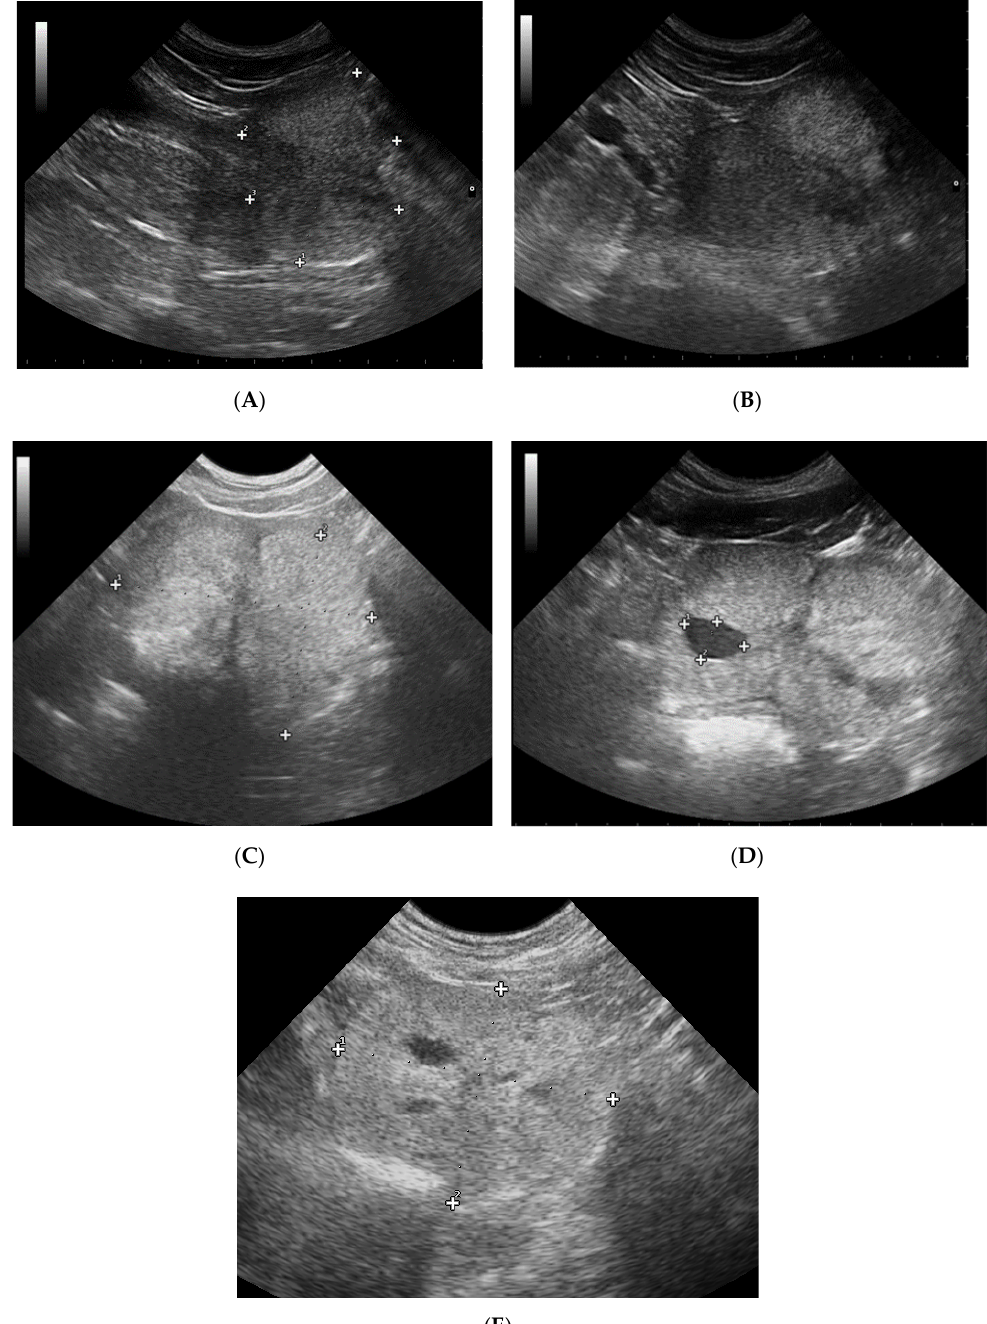
Figure 1. B-mode imaging of a normal prostate, and the most common appearance in dogs suffering from BPH. ( A )— normal prostate in transverse view, the thin echogenic capsular margins are indicated (+); ( B )— normal prostate in sagittal view; ( C )— Benign prostatic hyperplasia, prostate gland in sagittal view, hyperechoic parenchyma and mild enlargement; ( D )— BPH: large cyst; ( E )— BPH: small anechoic cysts in parenchyma.